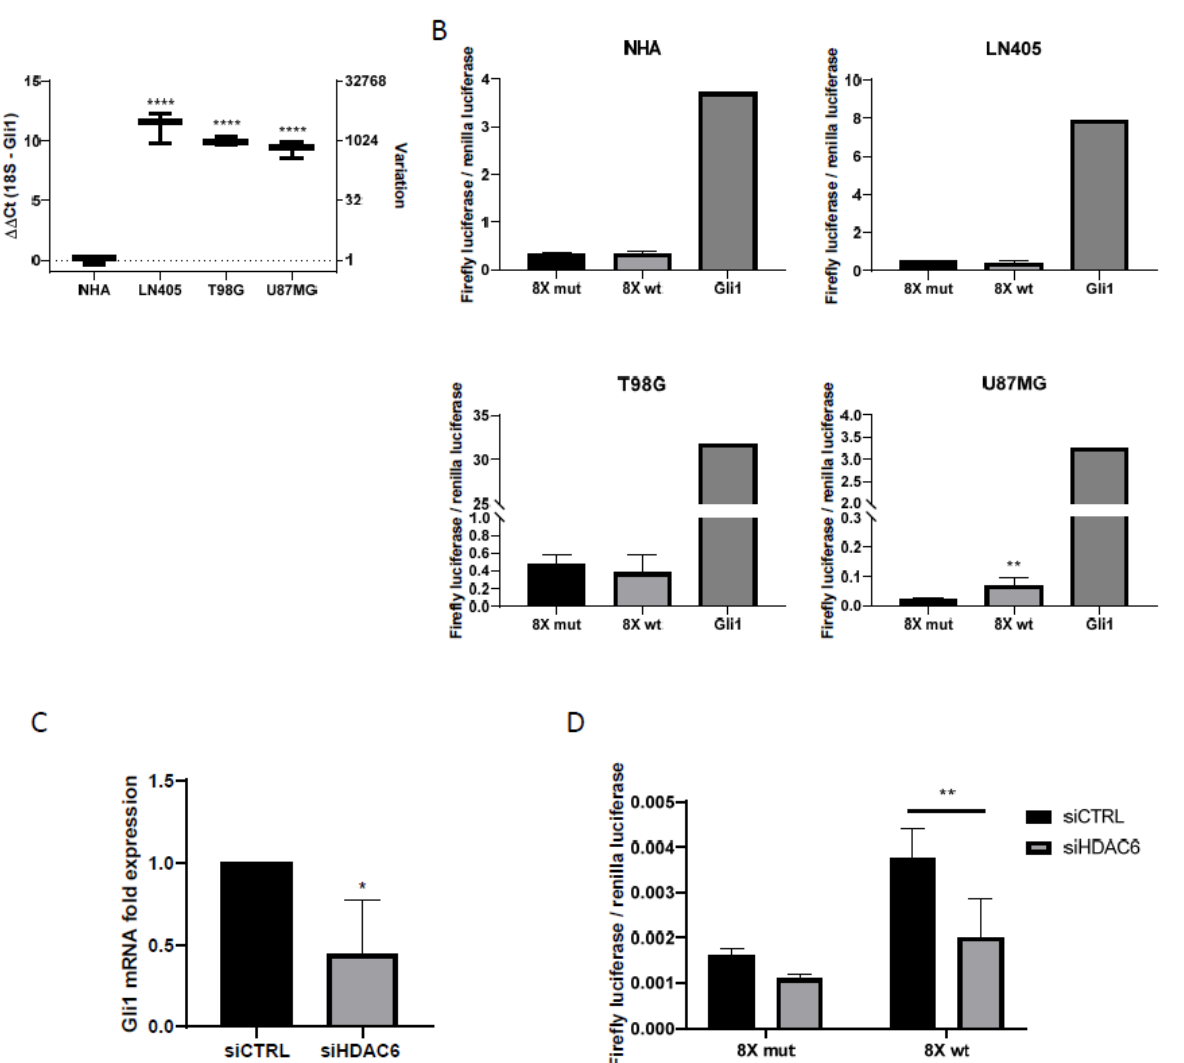
Figure 4. Shh pathway is only active in U87MG cells, and HDAC6 silencing inhibits this pathway. ( A ) RT-qPCR for Gli1 in human GBM cell lines and NHA cell line. Data are represented as mean ± SD (****) p < 0.0001 vs. NHA. ( B ) Gli1-luciferase assay in human GBM cell lines and NHA. Data are represented as mean ± SD (**) p < 0.01 vs. 8 × mut ( n = 4 of three independent experiments). ( C ) RT-qPCR for Gli1 in U87MG cell line after silencing of HDAC6. Data are represented as mean ± SD (*) p < 0.05 vs. siCTRL condition ( n = 3). ( D ) Gli1-luciferase assay in U87MG cell line after treatment with siRNAs. Data are represented as mean ± SD (**) p < 0.01 ( n = 4 of three independent experiments).